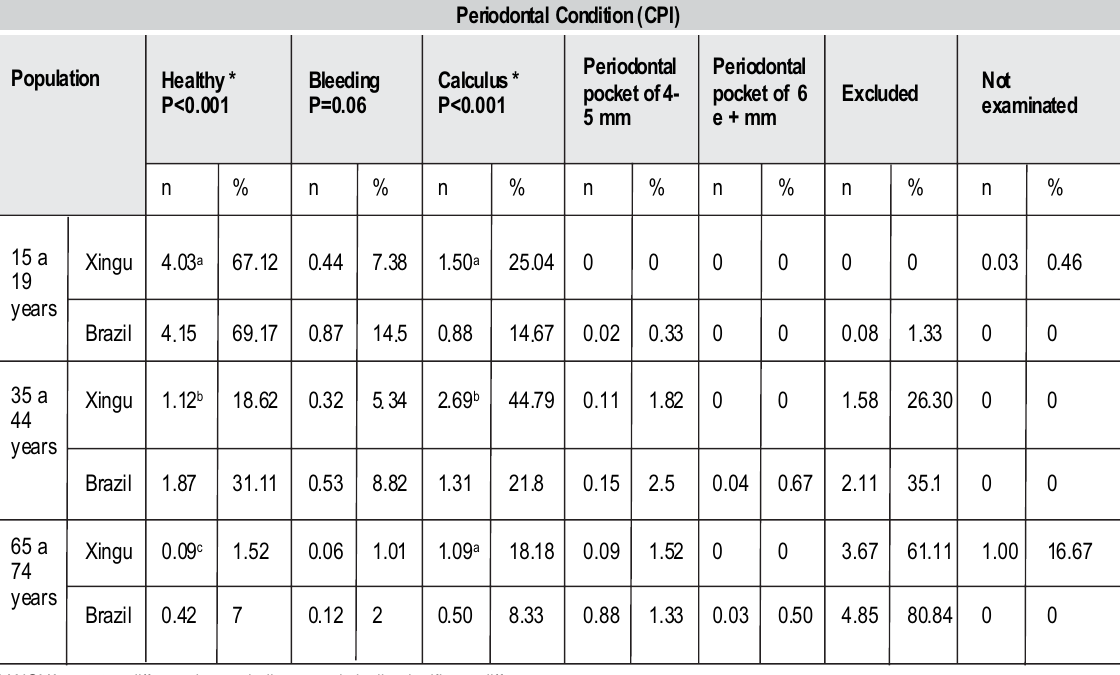
*ANOVA p<0.05; different letters indicate statistically significant difference respectively (Table 2). The prevalence of 4-5-mm-deep periodontal pockets, which indicates poor periodontal condition, was higher among the elderly, with 4.48% in the non-indigenous population and 9.09% in Xingu population.